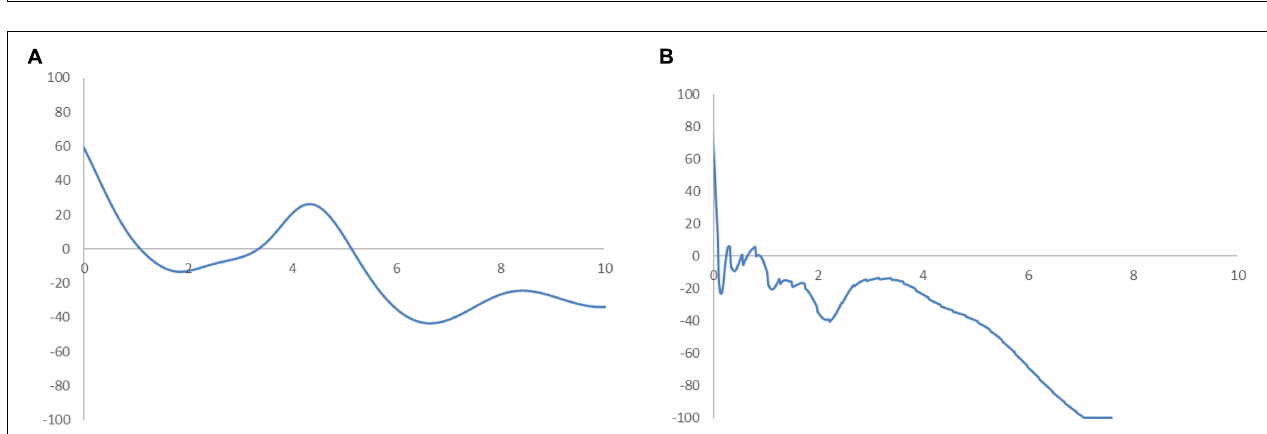
FIGURE 9 | Ergodic distributions for the RSVAPC of countries for the Global North (A) and the Global South (B) with annual transitions. Source: Authors’ calculation. N.B. The vertical axis indicates the density of probability and the horizontal axis indicates RSVAPC values.